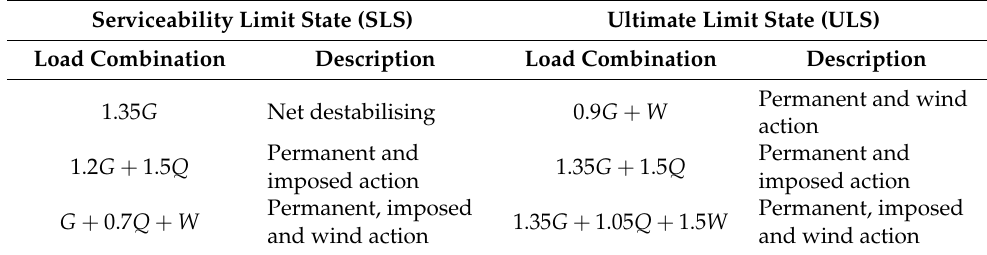
Table 4. SLS and ULS load combinations used in the analyses.